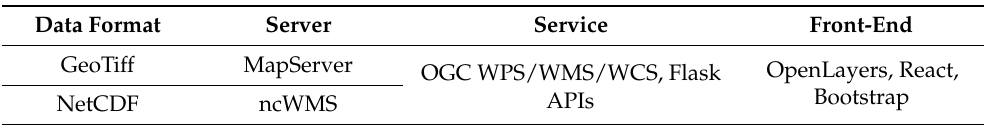
Table 2. Technologies used in